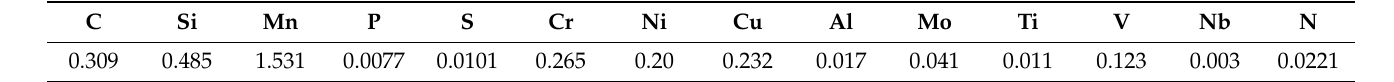
Table 1. Chemical composition of experimental steel